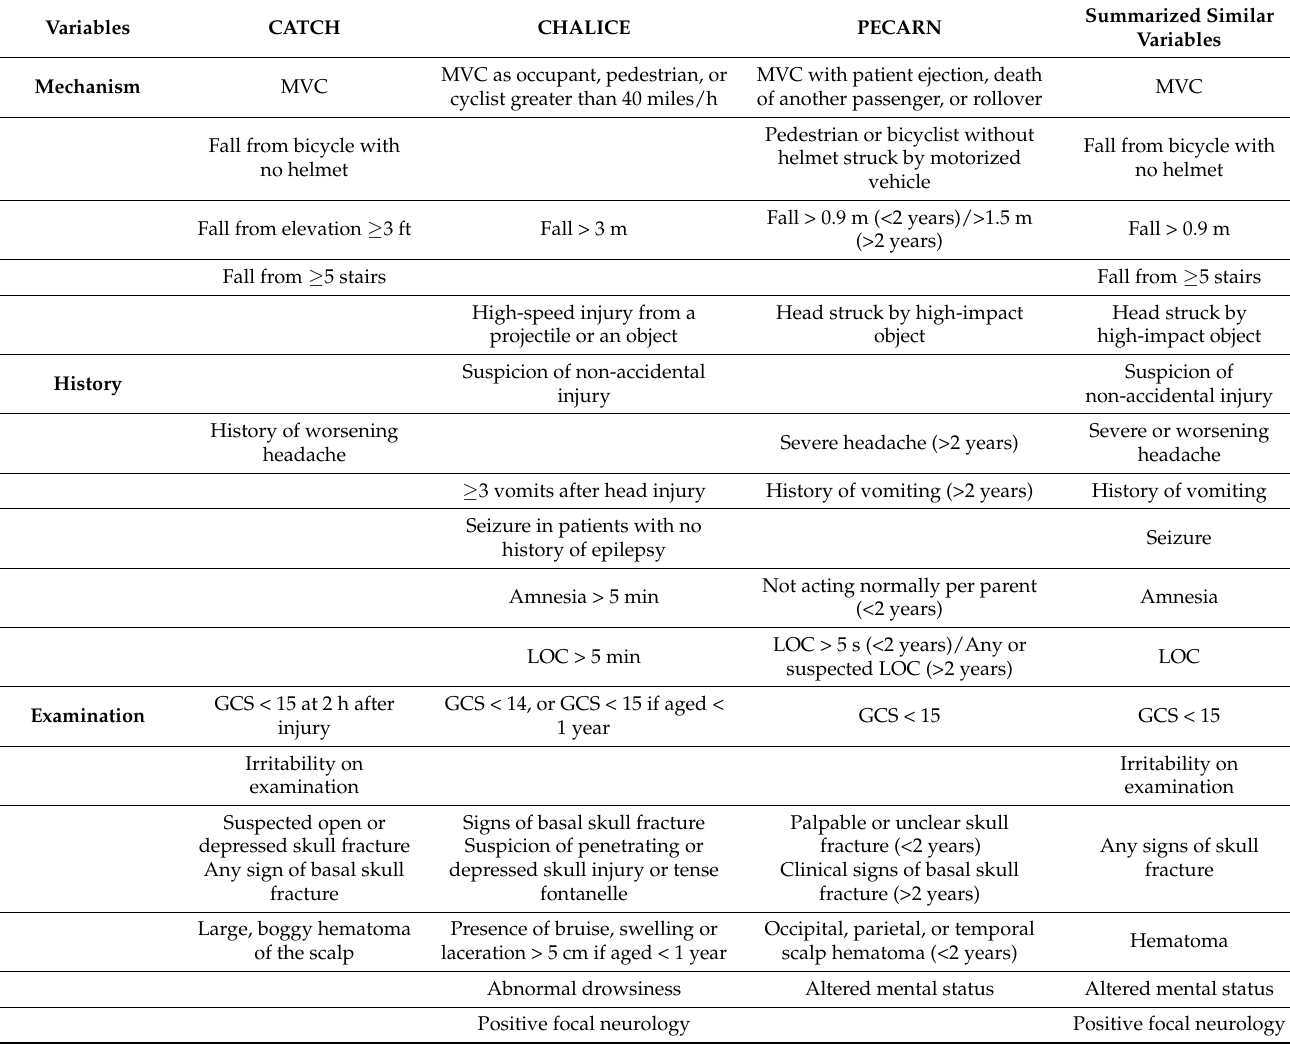
Table A1. Variables of CATCH, CHALICE, and